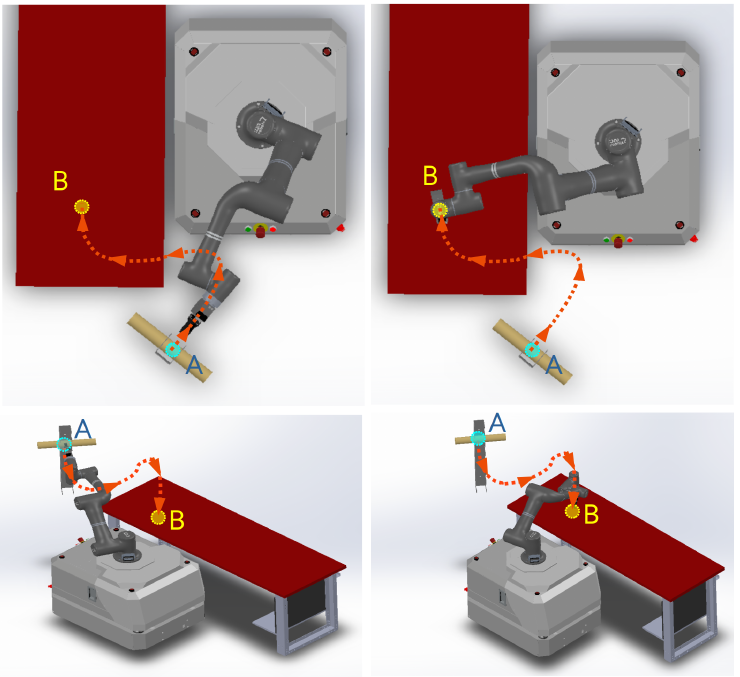
Figure 7. Graphical illustration of a transport task. The task relies on moving a piece, combined with the change of tool orientation. Symbols: A—pick-up point, B—put-down point. The detailed technical parameters of a research experiment are given in Table